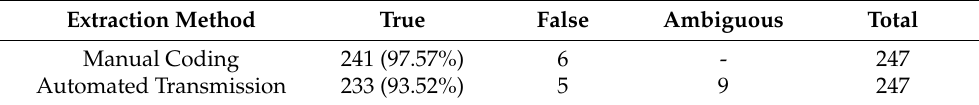
Table 2. Overall Correctness of Feature